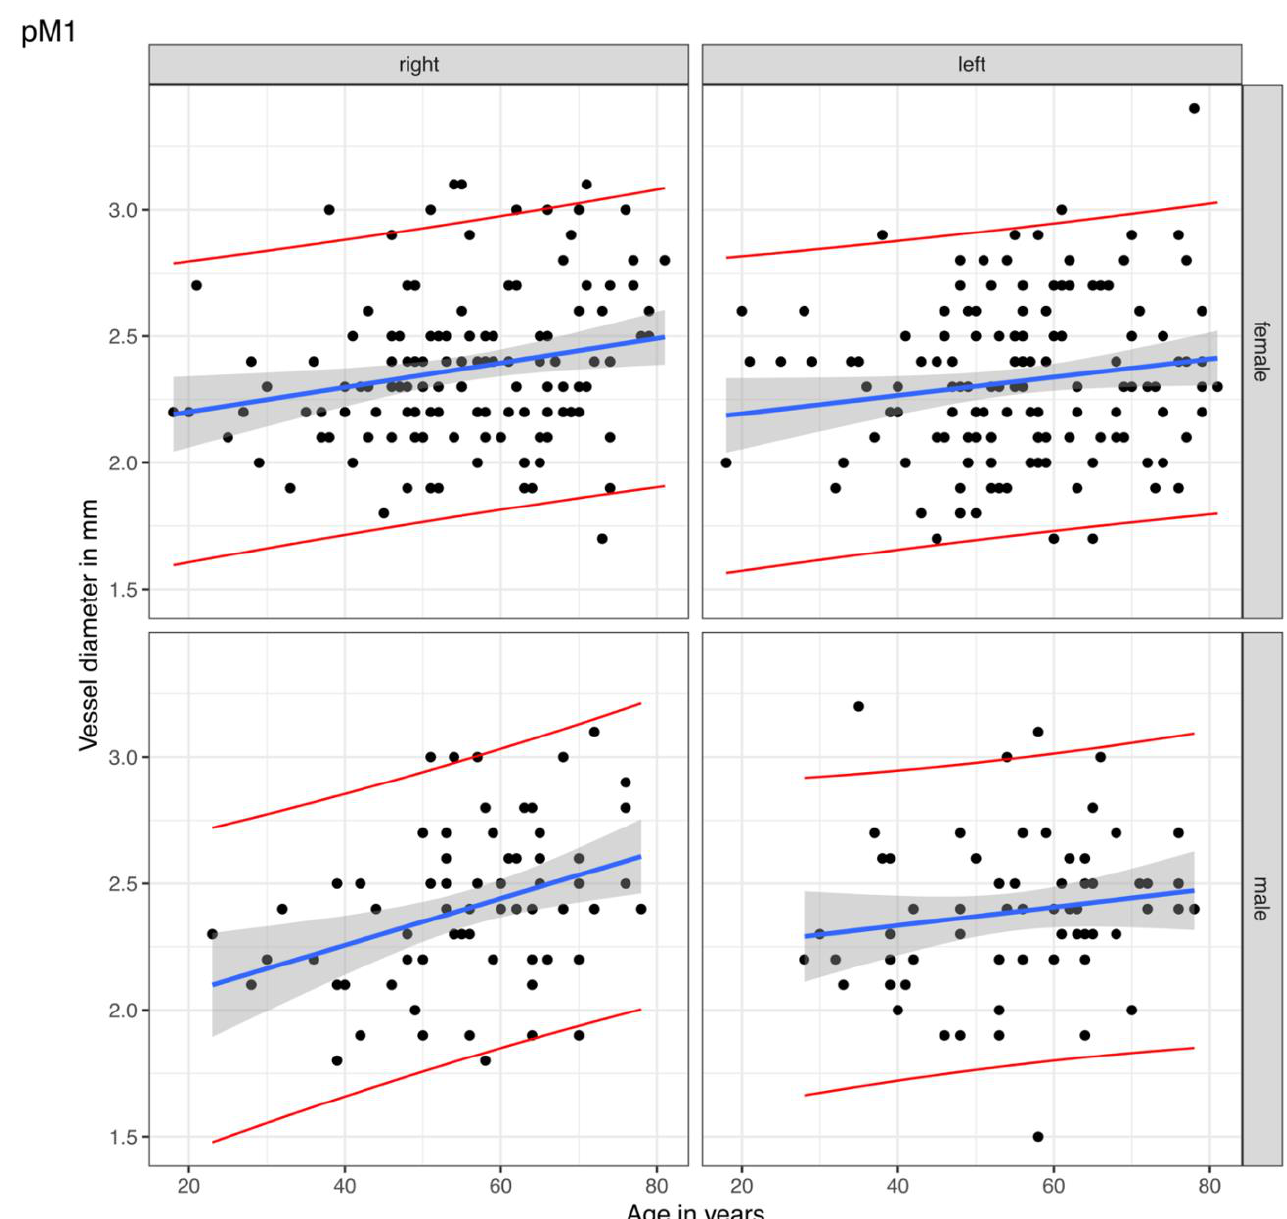
Figure 2. Linear regression of the vessel diameters for the proximal M1 segment. The points are the rectified measured values of the proximal M1 (pM1) segment of the middle cerebral artery in our study group. The blue lines display the calculated best-fitted line with the best-fitted values. The statistical variance is shown by the grey areas as a 95% confidence interval for the best-fitted lines of other study groups, i.e., one single measured value of the corresponding side, gender, and age would lie in between the red lines with a probability of 95%.